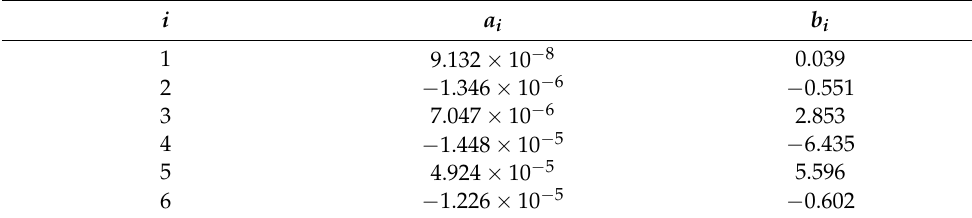
Table 4. The parameters of a i and b i